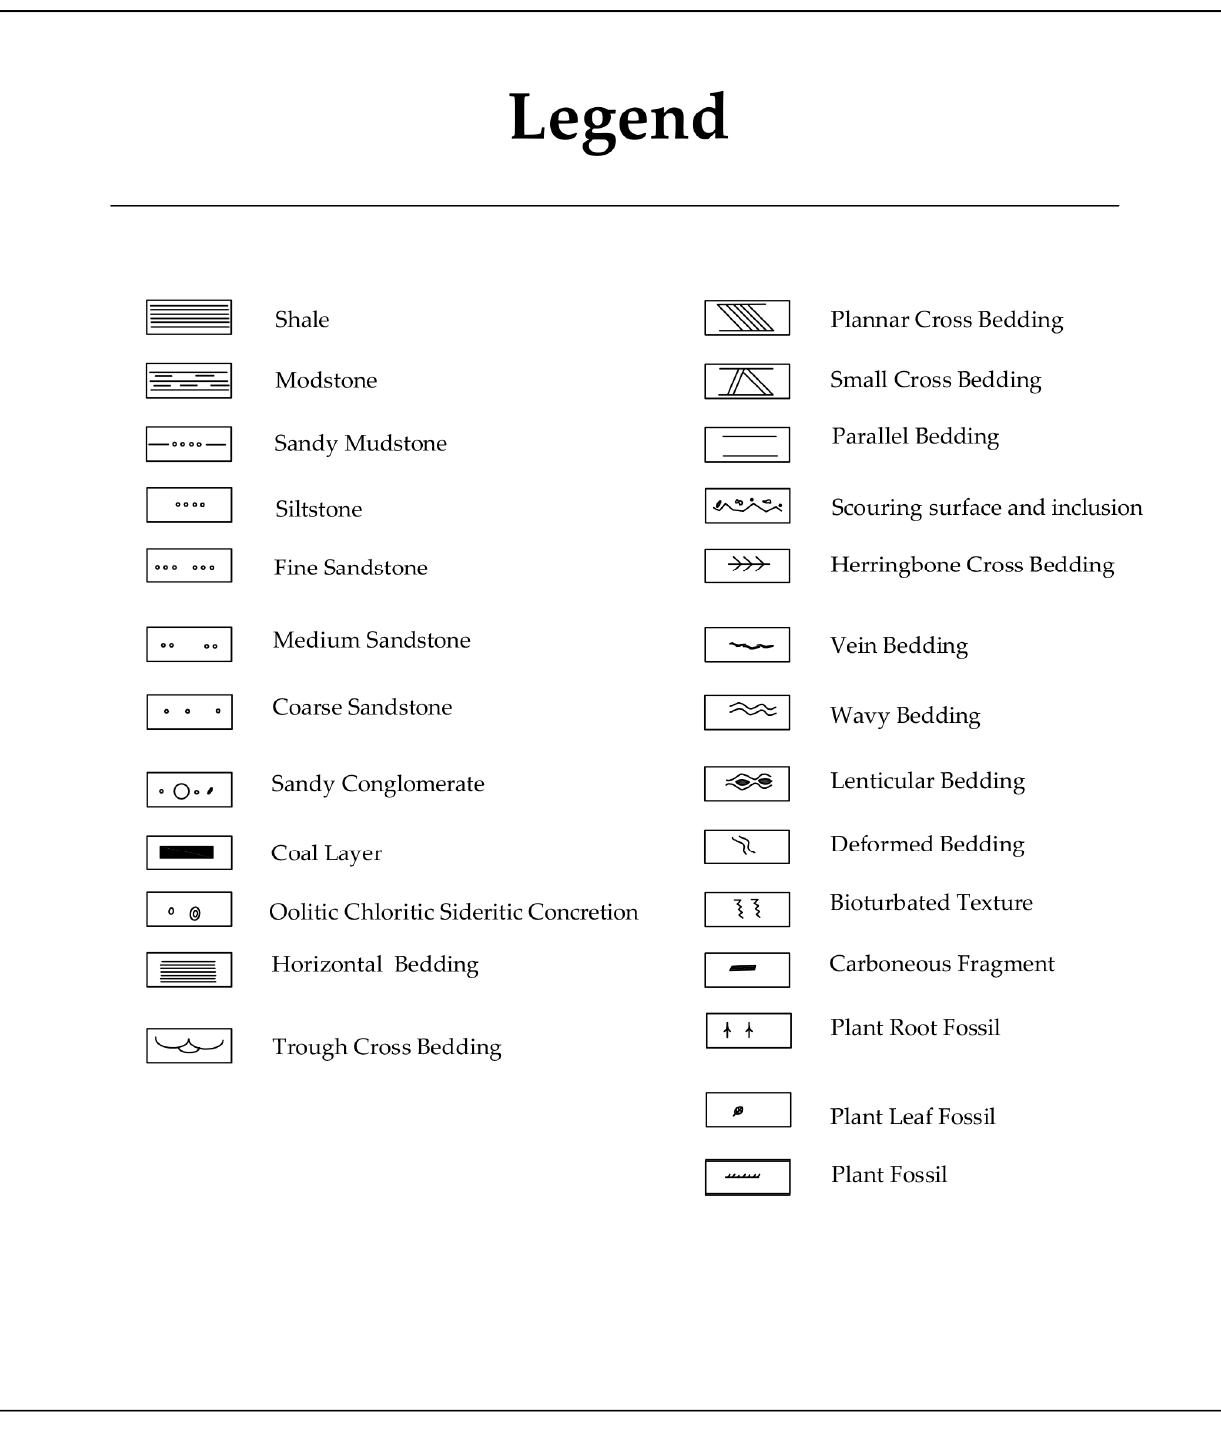
Figure A7. The legend of Figures A3–A6.